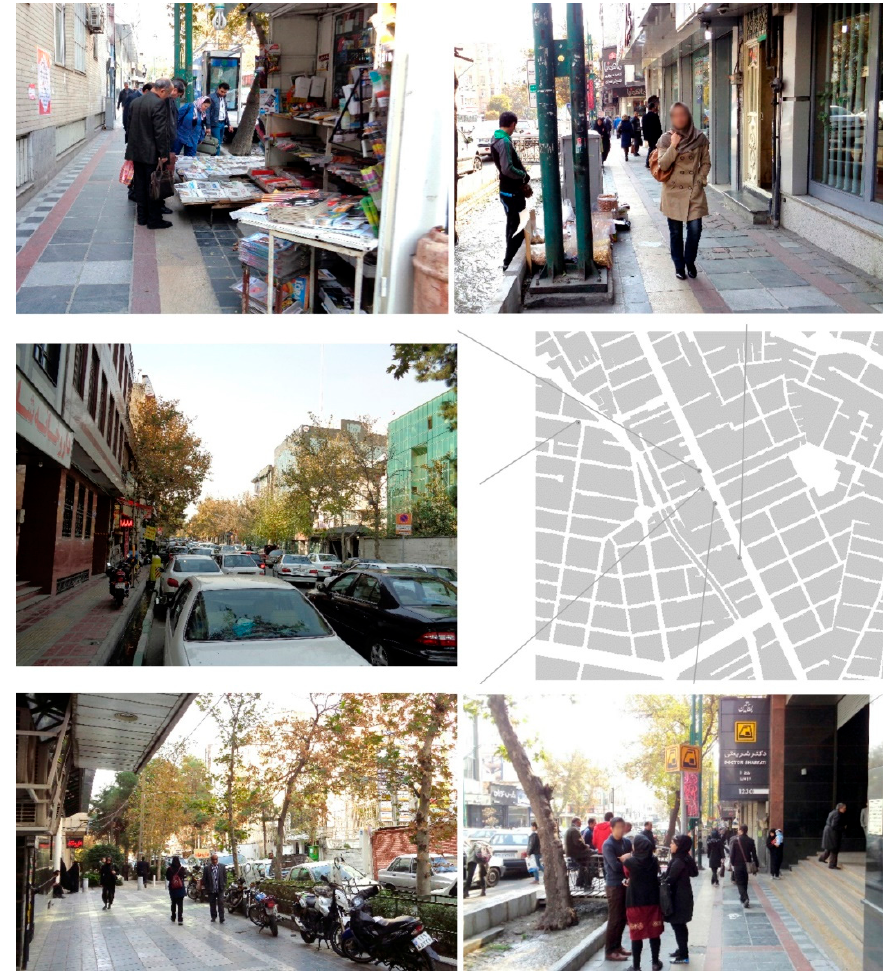
Figure 4. Stationary activities. The North: Shariati. Photos: Nastaran Peimani.